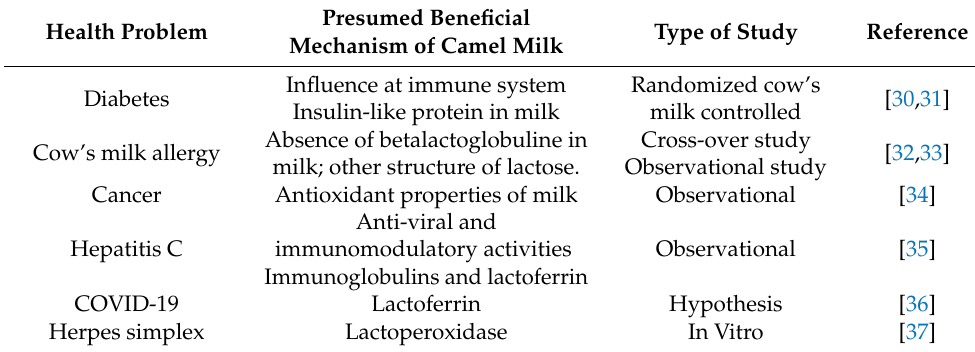
Table 1. Presumed medicinal properties of camel milk, ascribed working mechanisms and type of most relevant studies, based on PubMed search using the words camel milk and the presumed medicinal